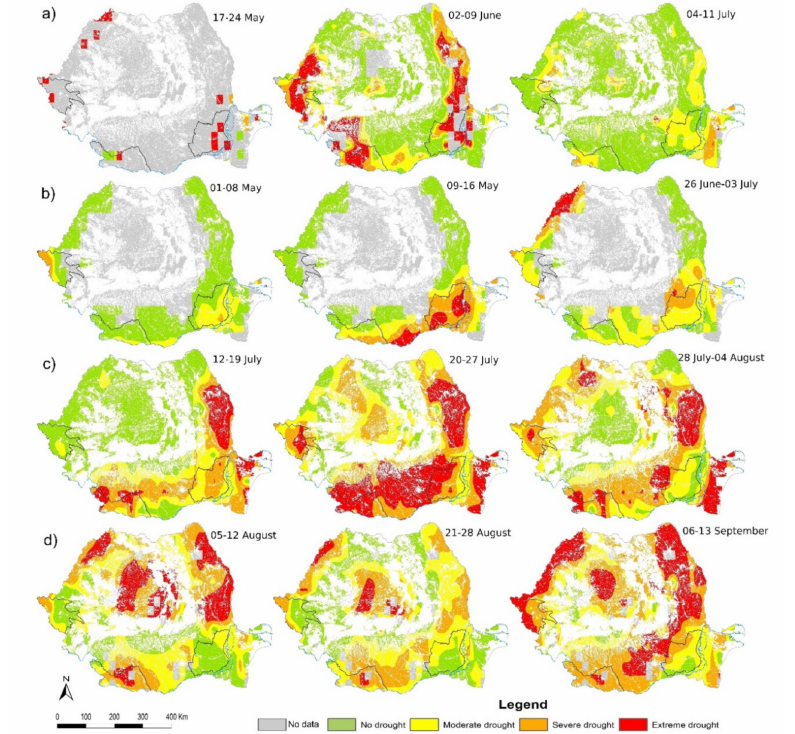
Figure 4. Soil Moisture Anomaly in the agricultural areas of Romania in: ( a ) 2002; ( b ) 2003; ( c ) 2007; ( d )